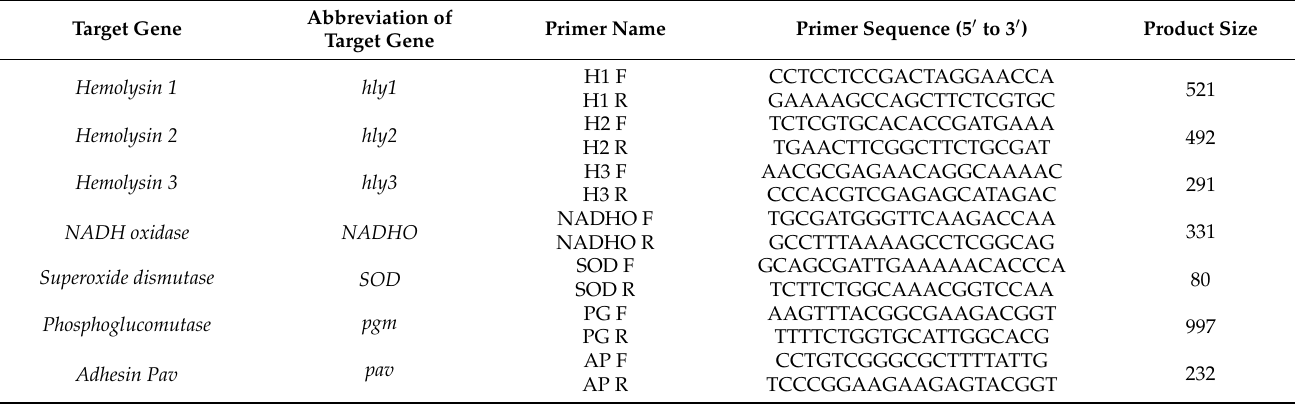
Table 1. Primers of